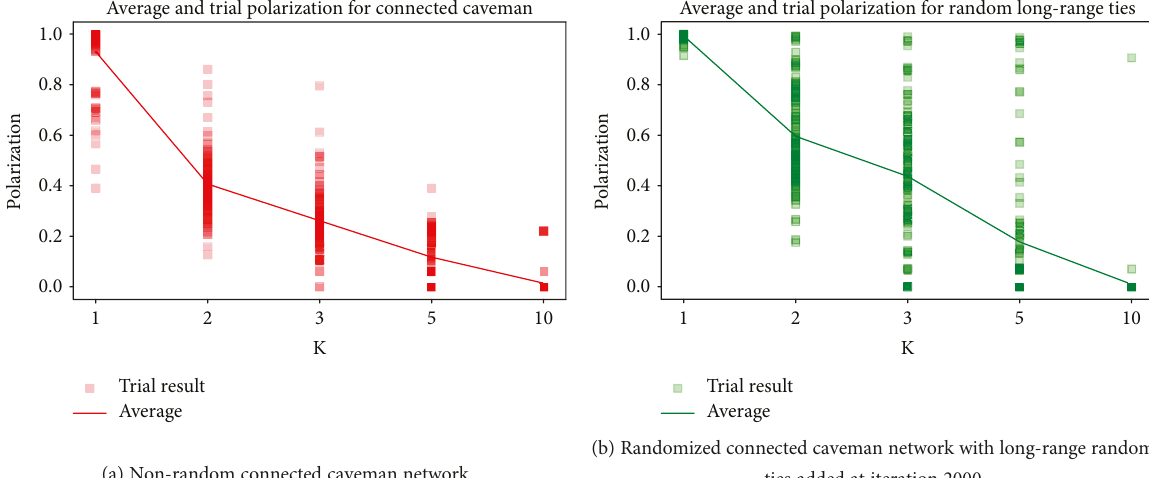
Figure 4: Results of individual model runs under di ff erent network conditions. The averages of these are shown in Figure 3. Even in the nonrandom connected caveman structure, there is variation in the fi nal polarization for di ff erent values of K . Highly polarized fi nal states may obtain even for large K . 100 trials are shown for each network condition. Solid lines indicate the average across all trials.